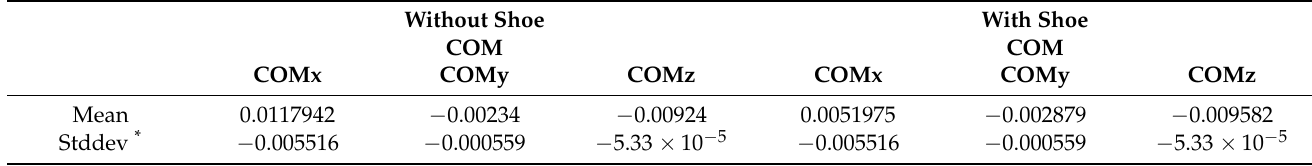
Table 1. Mean and standard deviation of COM variables (displacement).